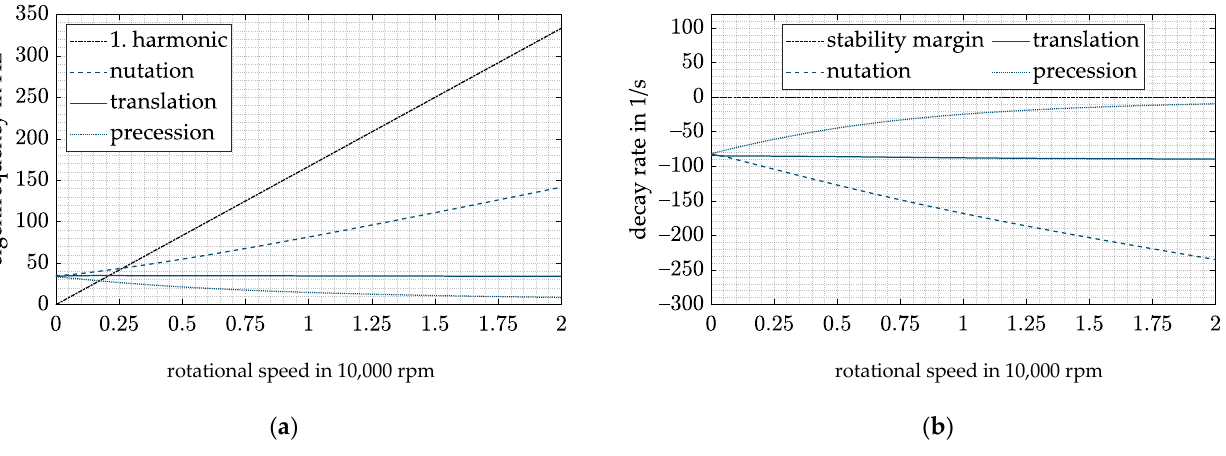
Figure 13. Extended CFC and DVFC with C att = 0.5 : ( a ) Campbell diagram; ( b ) decay rate.